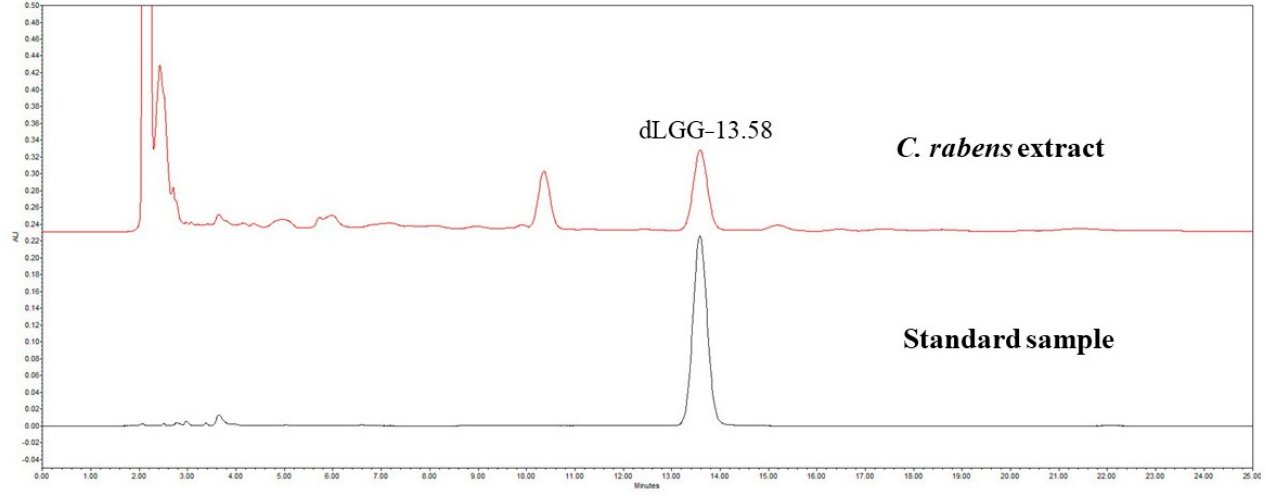
Figure 1. HPLC analysis for dLGG in the C. rabens